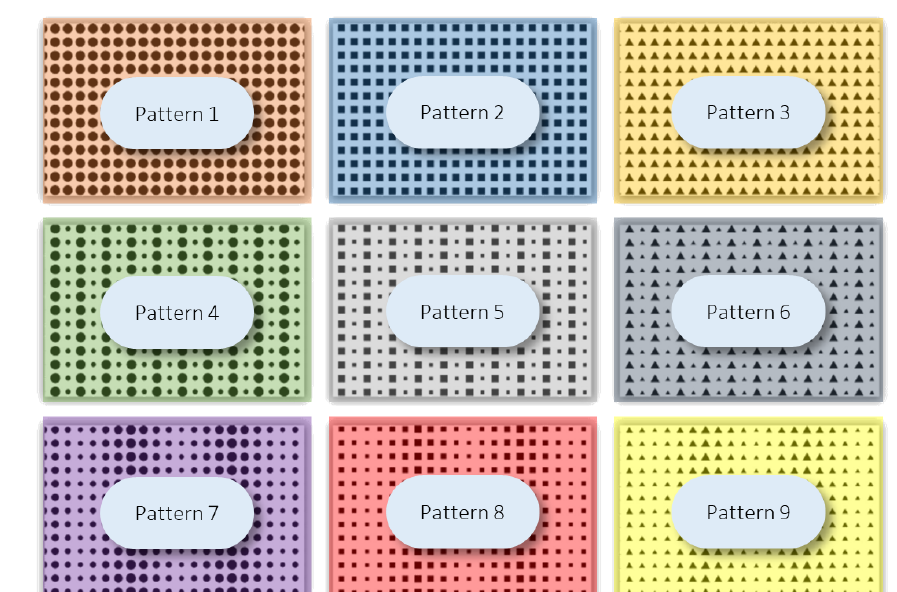
Figure 21. Area of interest